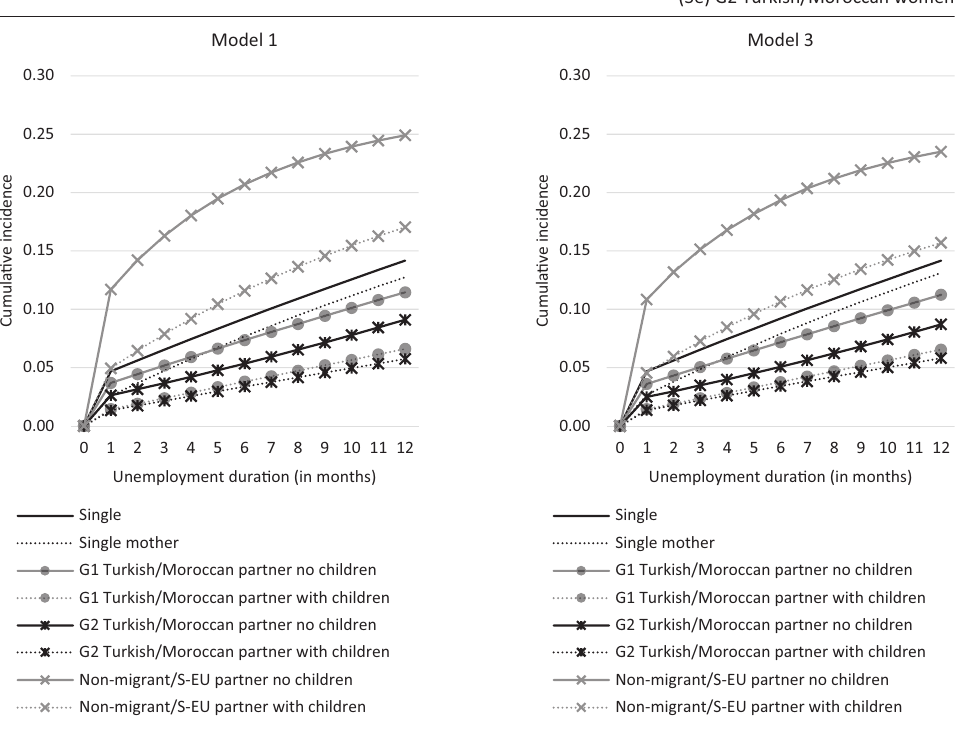
Figure 3. Cumulative incidence of training uptake by migrant origin group and household composition. Model 1 reflects gross differentials, while Model 3 controls for period variation and human capital characteristics. The sample is restricted to women who had been in unemployment between 2007 and 2016. Source: Calculations by authors based on the MIA Panel